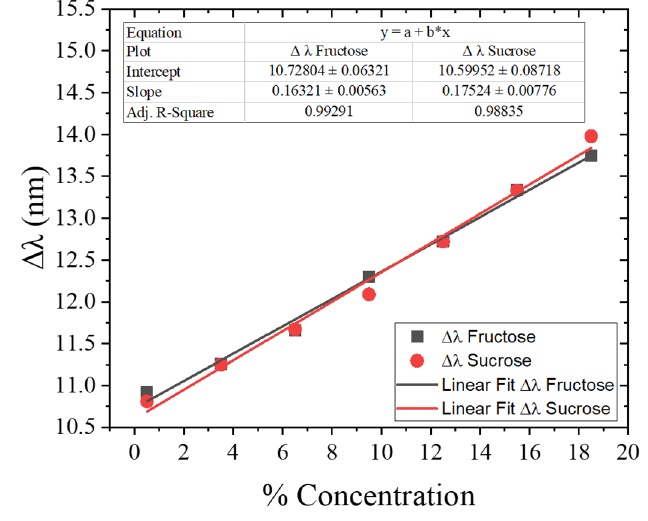
Figure 3. Displacement of the wavelength peak for each concentration. As is shown, the sensor exhibits a linear response with a sensitivity of 0.17524 nm/% and 0.16321 nm/% for sucrose and fructose, respectively. To obtain the level of error, three representative samples were selected from the original sample set: 6.5%, 12.5%, and 18.5%, and their response was measured in triplicate by following the same measurement procedure described above. From the standard deviation, we obtained a variability of 0.13565 nm and 0.09043 nm for sucrose and fructose, respectively.